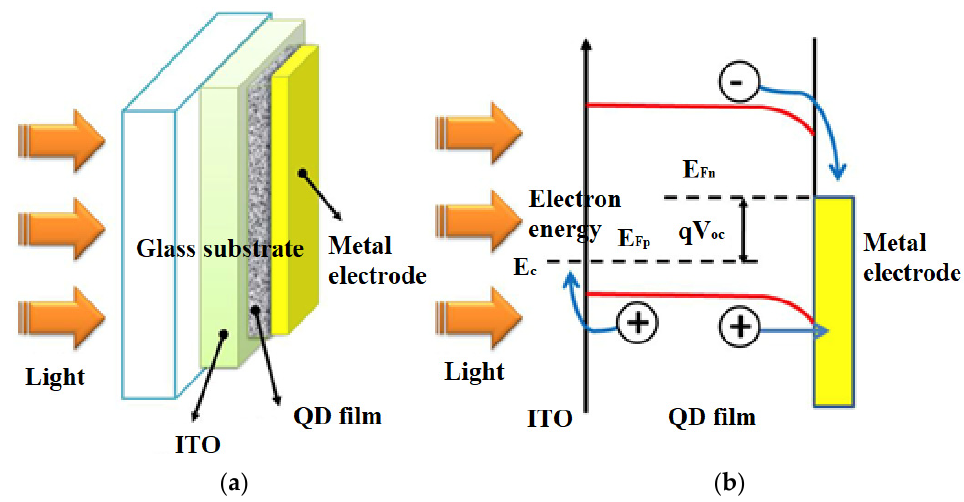
Figure 14. ( a ) A scheme of a solar cell based on quantum dots, ( b ) solar cell band diagram [64].